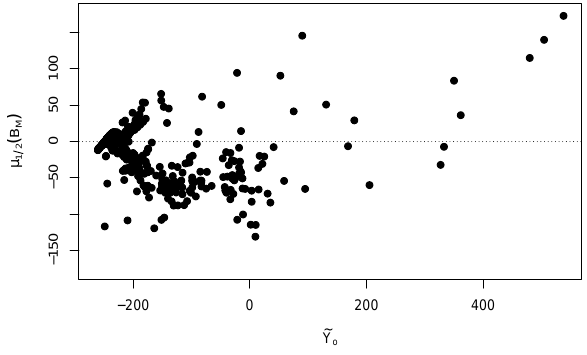
Fig. 6. Median of model inadequacy versus transformed observed runoff for the calibration period shown in Fig. 4. Results are shown for the best solution: the constant bias log-sinh transformed error model.